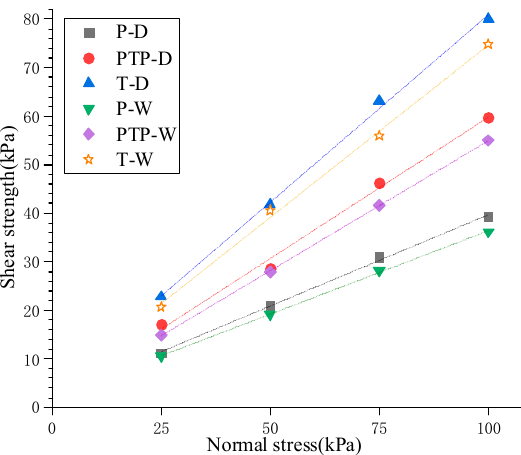
Figure 10. Comparison plot of failure envelopes of the shear strengths of di ff erent interfaces. To investigate the e ff ect of interfacial type and dry-wet state on the indexes of interfacial shear strength, the relationships between the interfacial shear strength indexes and interfacial type under di ff erent dry–wet states were plotted in Figure 11.